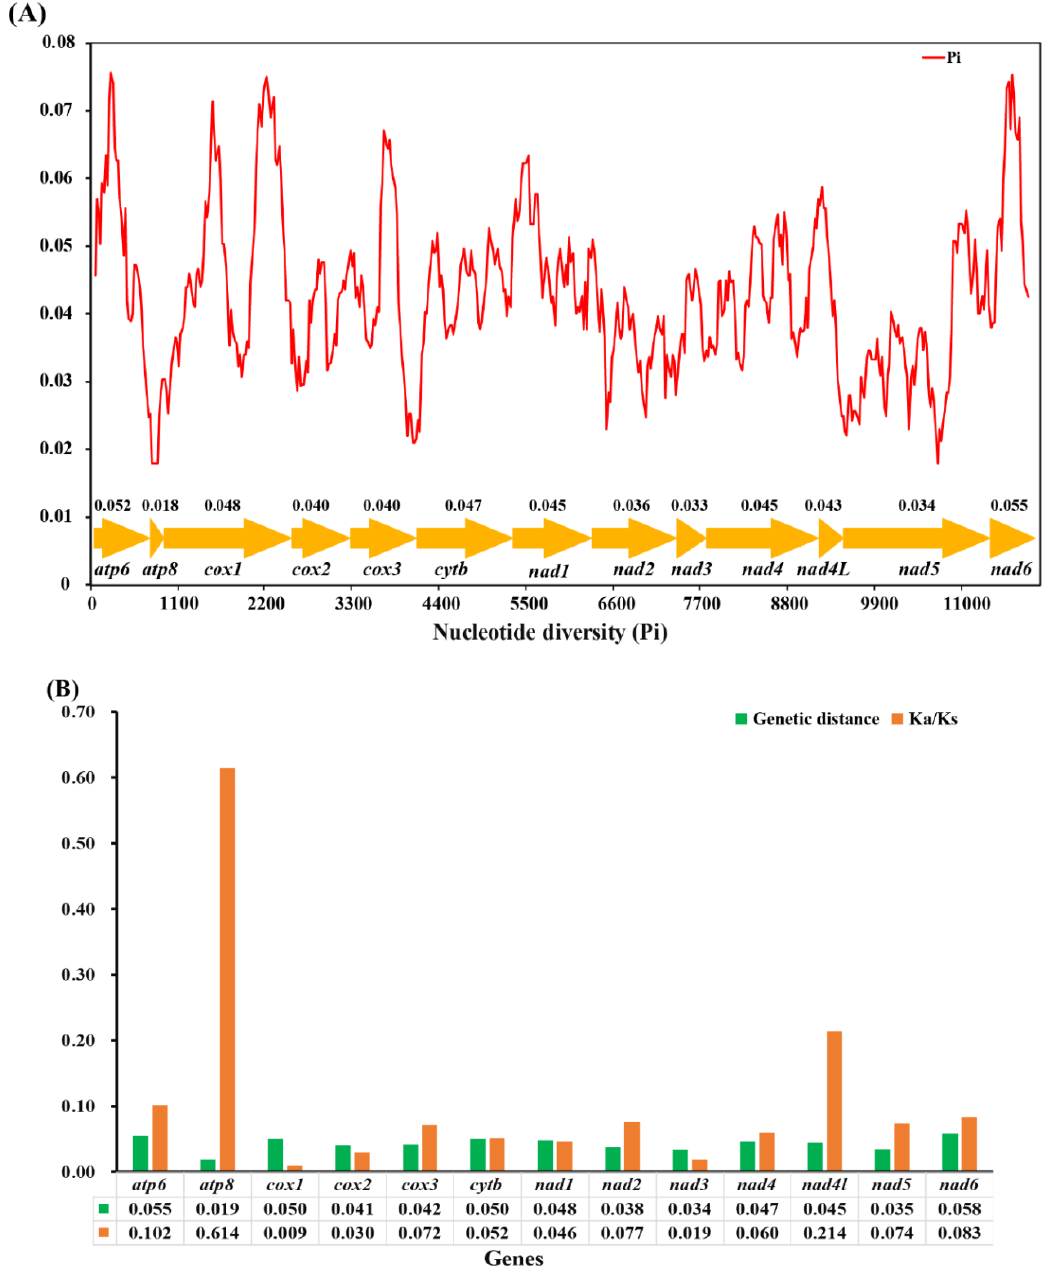
Figure 5. ( A ) Sliding window analysis based on 13 aligned PCGs. The red line shows the value of nucleotide diversity Pi (window size = 200 bp, step size = 20 bp). The gene names and Pi values are shown in the graph. ( B ) Genetic distance (on average) and non-synonymous (Ka) to synonymous (Ks) substitution rates of 13 PCGs among six Ostrinia spp.